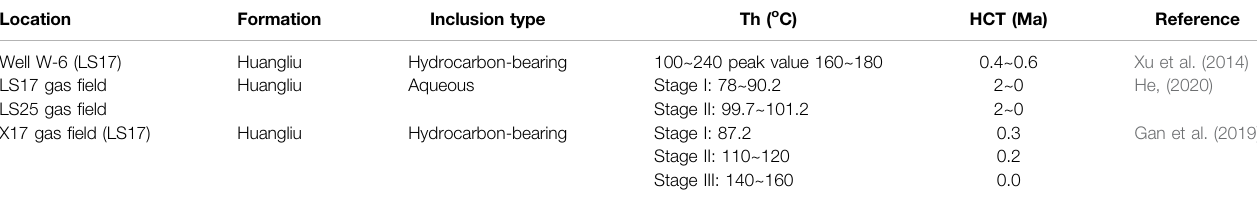
TABLE 3 | Homogenization temperatures (Ths) of coexisting aqueous inclusions and hydrocarbon charging time (HCT) of the large gas fi elds in the Lingshui Sag.